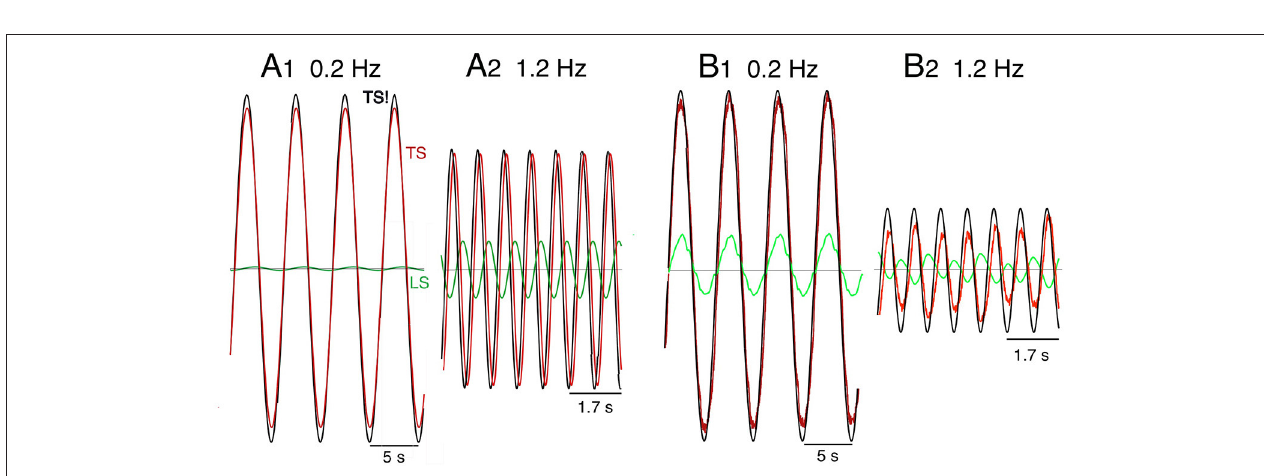
FIGURE 6 | The gain (A) and phase (B) characteristics of the theoretical F qq t (curves) and experimental F qq e (data points) transfer functions of the desired kinematics to the actual kinematics in terms of joint angles q. Experimental points: ◦ - F qq e 11 , (cid:3) F qq e 21 , H F qq e 12 , ♦ F qq e 22 .